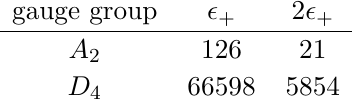
Table 12 . Numbers of possible terms in the numerators of the elliptic genus for 1 string in terms of Weyl invariant Jacobi forms with SU(2) R elliptic parameter (cid:15) + vs. 2 (cid:15) +